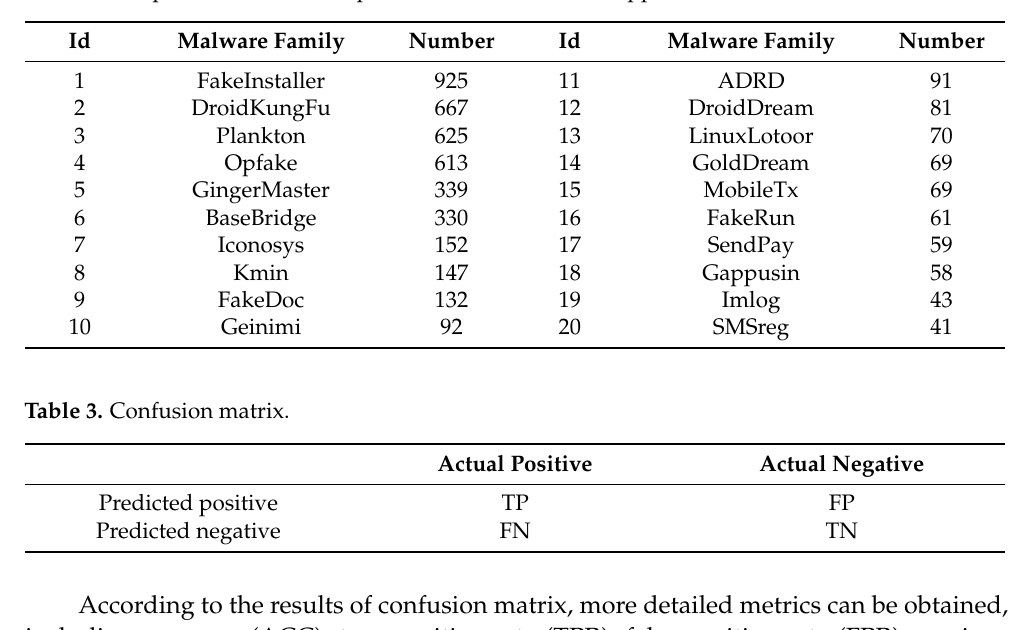
Table 2. Sample distribution of top-20 families of malicious apps.